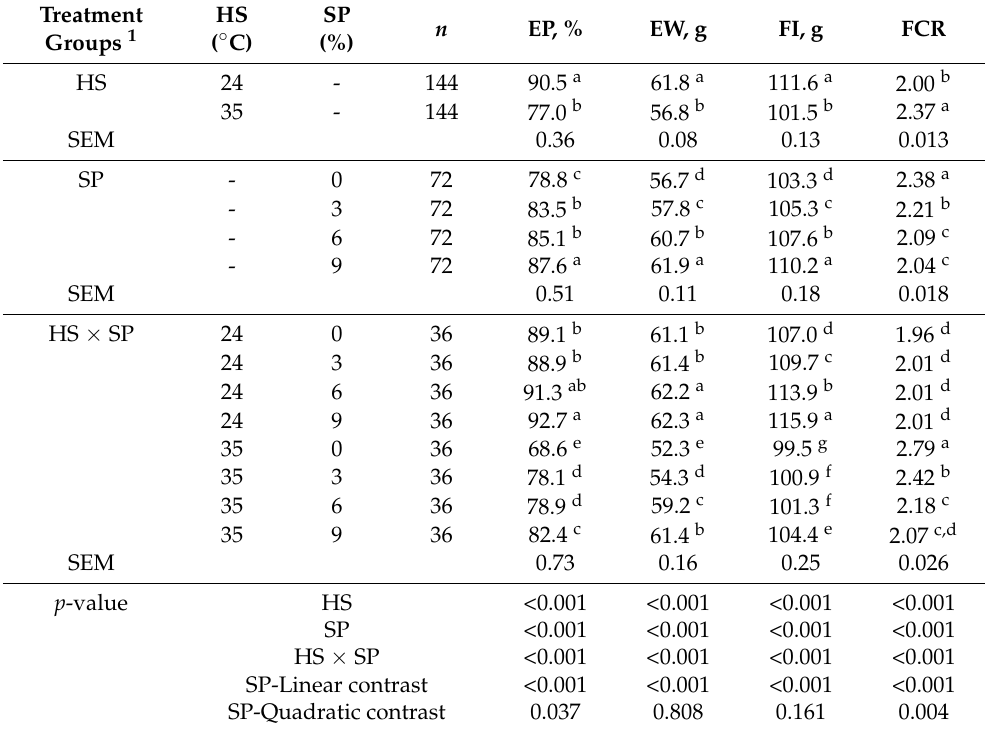
Table 6. Effect of dietary Spirulina platensisis (SP) supplementation on the productive performance of laying hens exposed to cyclic heat stress